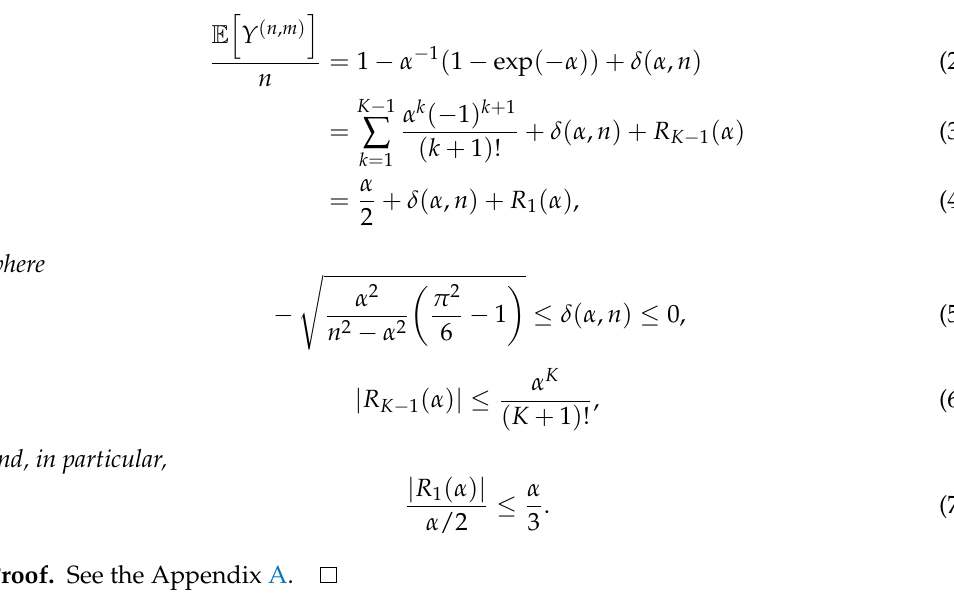
Figure 3. Numerically computed value of log function of the number of inserts n and the number of buckets m . With log instabilities appear for values of log